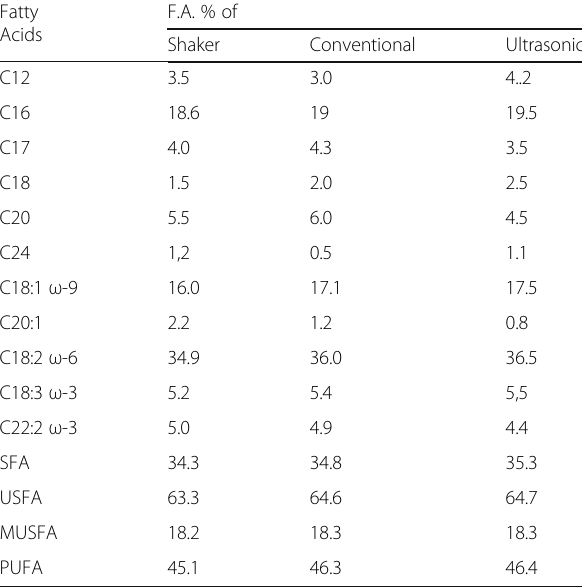
Table 2 Fatty acids profile of blank samples oil extracted by different methods using ethanol Fatty F.A. % of Acids